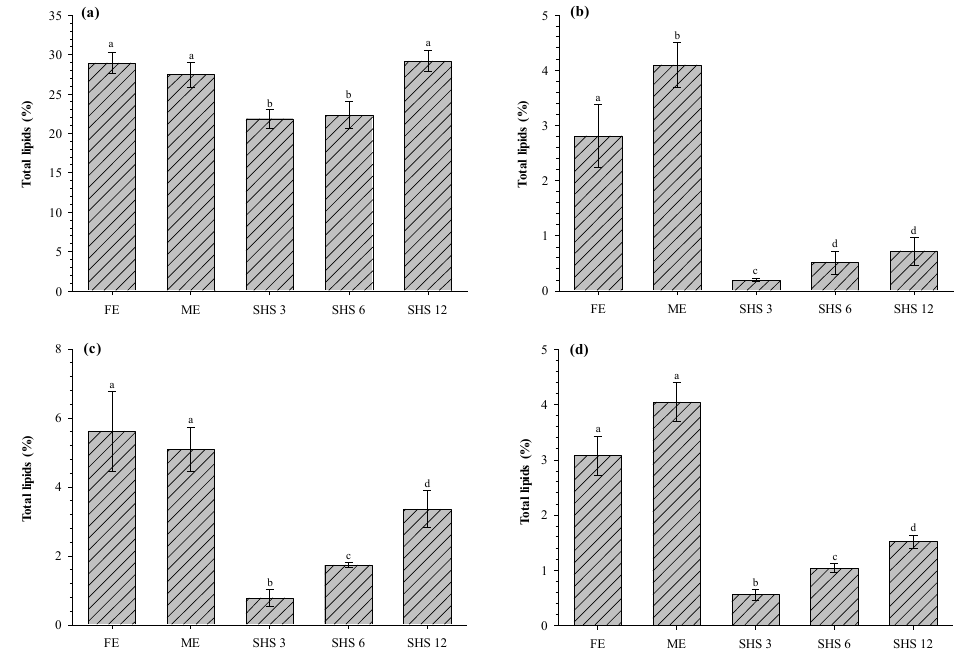
Figure 3. Comparison of different extraction methods (Folch, Mojonnier, and switchable hydrophilicity solvent) on the lipids recovered from ( a ) raw cream, ( b ) buttermilk, ( c ) concentrated buttermilk, and ( d ) beta-serum. FE: Folch extraction; ME: Mojonnier extraction; SHS 3, 6, 12: switchable hydrophilicity solvent ratio 1/3, 1/6, 1/12, respectively. Mean ± standard deviation within each column with different letters ( a – d ) are significantly different ( p < 0.05) according to Tukey test.